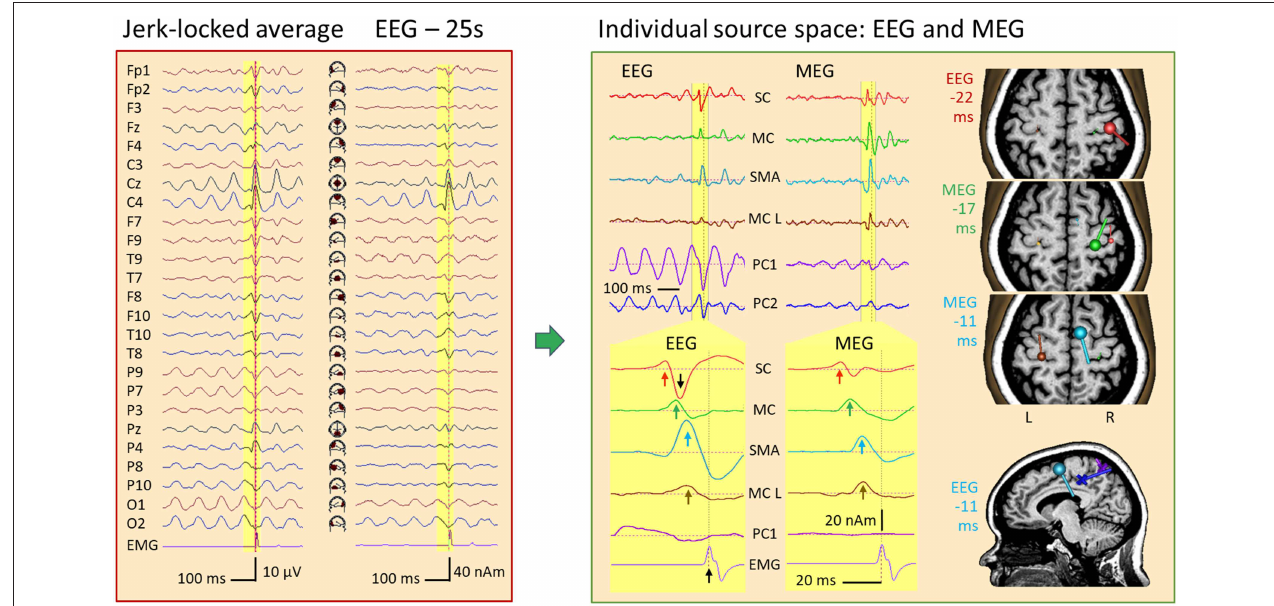
FIGURE 14 | IED in a case of myoclonic epilepsy. Left: jerk-locked average displayed in scalp EEG montage Av25 and source space 25. The motor potential (MP) preceding the left-hand jerk (EMG/FDIL at bottom) is riding on a central 10-Hz EEG rhythm and is most prominent below C4 in source space 25. Right: An MDS model with 4 dipoles and 2 PCA-components modeling the parietal (PC1) and central (PC2) 10-Hz oscillations separates the sharp jerk-locked transient in the wideband EEG and MEG averages from the rhythmic activities (right top). After expanding time scale for better visualization of the yellow pre-jerk epoch, and forward filtering (see text), 4 components could be isolated both in EEG and MEG (for details, see text): IED onset in right somatosensory cortex (SC, red, 22ms prior to jerk), discharges of right motor knob (MC, green, − 17ms), SMA (blue, − 11ms) and contralateral, left motor knob (MC L, brown, − 10ms). The orientation and strength of source current at these times is illustrated by the dipoles in the slices of the individual MRI, colored accordingly. The posterior mid-line centers of the oscillatory EEG components PC1 and PC2 are shown by crosses in the sagittal slice at − 11ms.